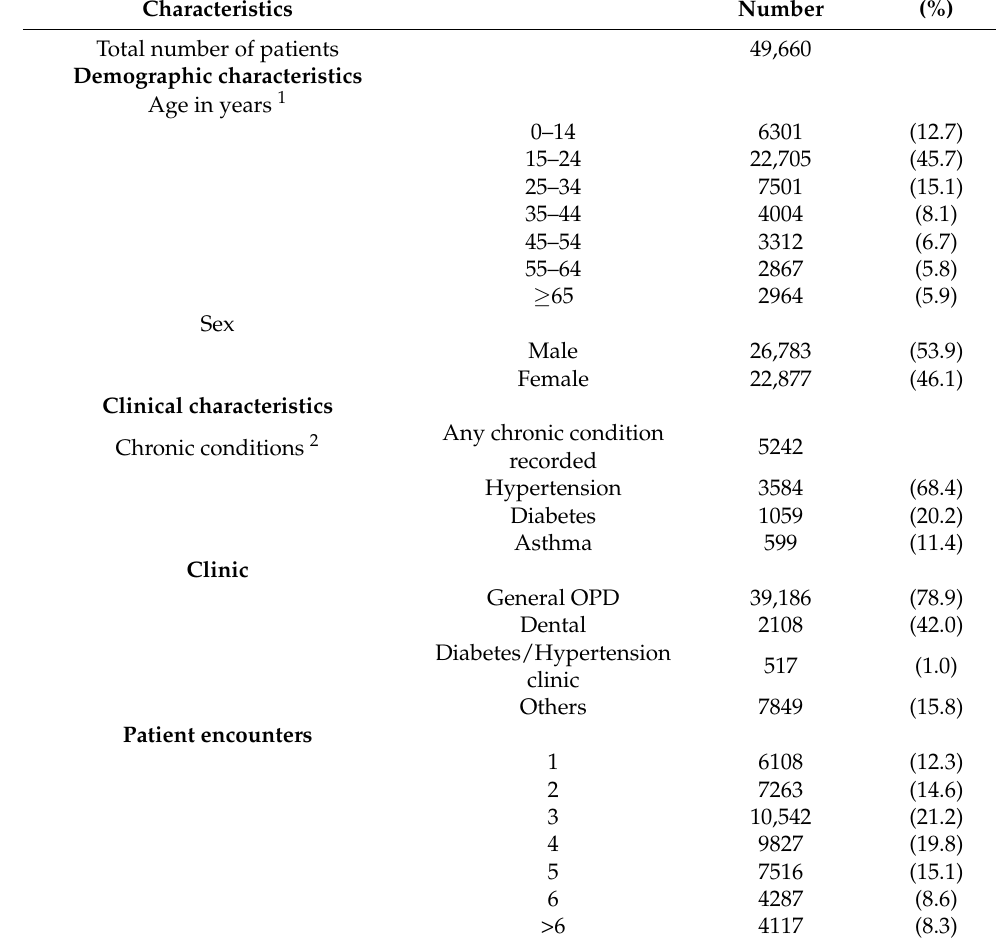
Table 1. Demographic and clinical characteristics of patients attending the OPD of University Hospital, KNUST, between January and December